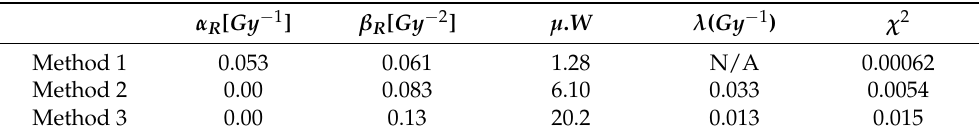
Table 3. Values of the parameters used in the bystander effect simulation model for NCI-H460 cells [21]. Source of the experimental data: [21].